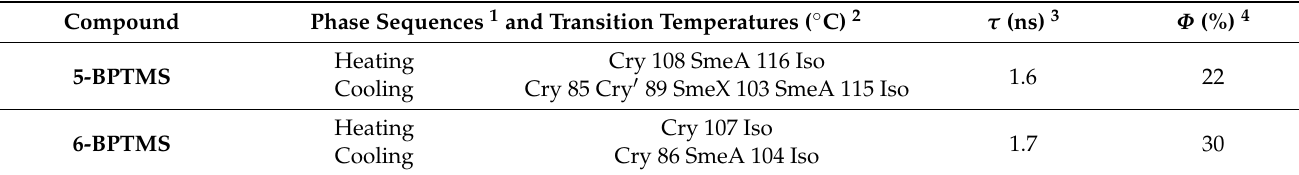
Table 2. Thermal and photophysical properties of biphenylacetylene compounds. Compound Phase Sequences 1 and Transition Temperatures ( ◦ C) 2 τ (ns) 3 Φ (%) 4 Heating Cry 108 SmeA 116 Iso Cooling